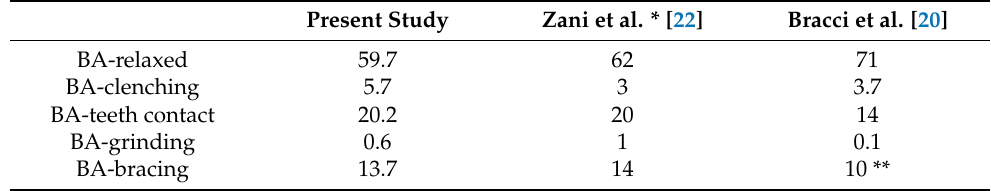
Table 3. Frequencies of the ecological momentary assessment (EMA) conditions (%)—comparison among studies. Present Study Zani et al. * [22] Bracci et al. [20] BA-relaxed